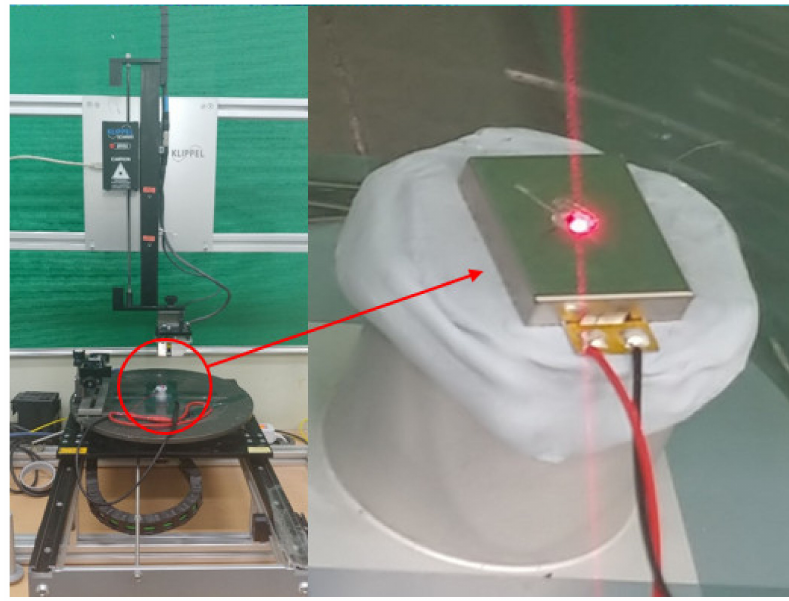
Figure 6. Klippel equipment.